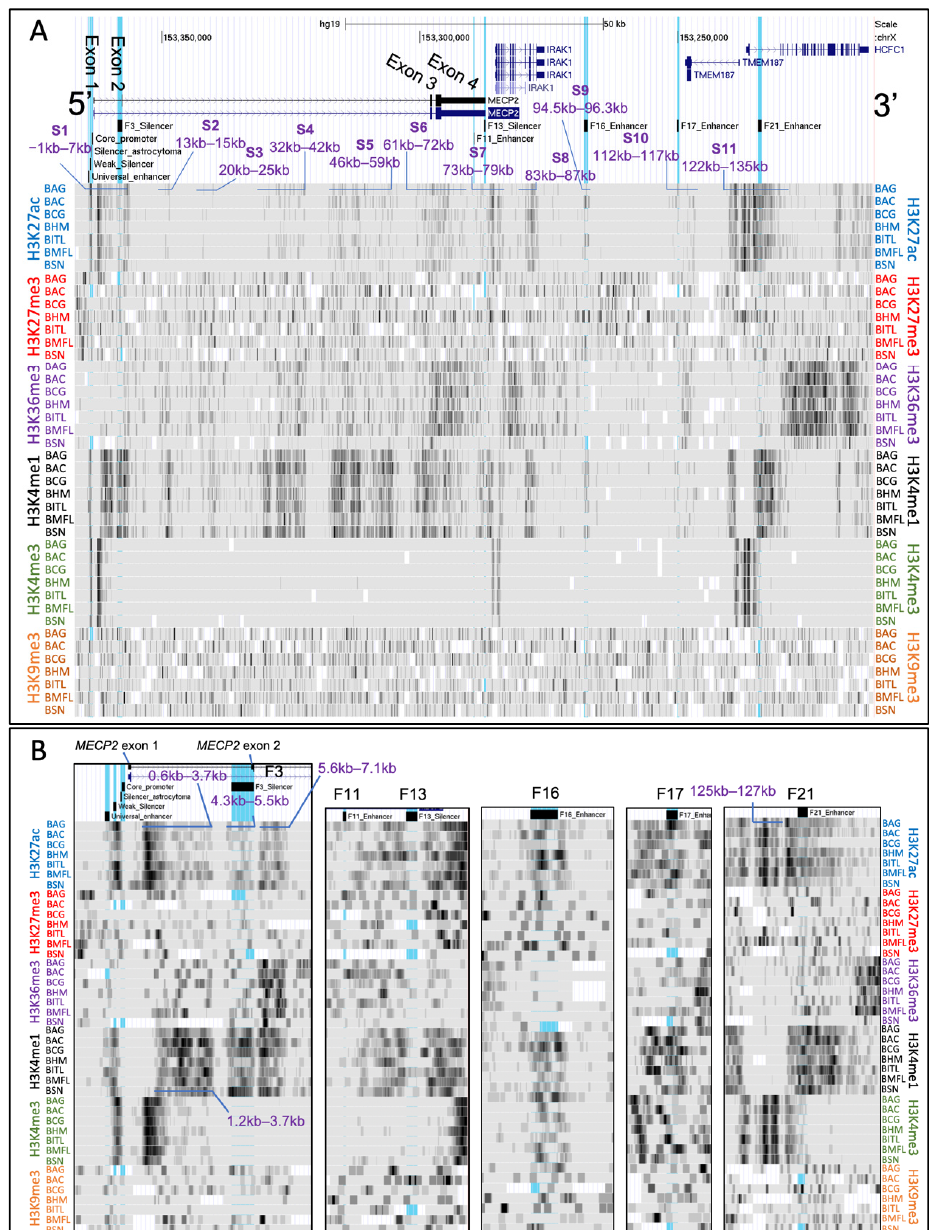
Figure 3. Histone post-translational modification profiles of 7 brain regions. ( A ) The chrX:153,212,176–153,366,832 genomic region of hg19 human genome assembly is displayed in UCSC genome viewing browser. Direction is 5 ′ –3 ′ (sense orientation relative to the MECP2 gene). Tracks displayed from top to bottom: UCSC genes, mapping of previously identified [55] cis- REs (F3-F21) to genome, histone modification CHIP-seq data tracks. Cis -regulatory elements (REs) are highlighted in blue in UCSC. Scale on top represents distance equivalent to 50 kb. MECP2 exons are labeled on UCSC Genes data track. Genomic segments with consistently high H3K27ac and H3K4me1 were labeled S1–S11. The distances are relative to the first nucleotide of MECP2 exon 1 (hg19 chrX:153,363,188). Labels consist of 3 letter code for brain region followed by histone PTM type. BAG: brain angular gyrus, BAC: brain anterior caudate, BCG: brain cingulate gyrus, BHM: brain hippocampus middle, BITL: brain inferior temporal lobe, BMFL: brain mid frontal lobe, BSN: brain substantia nigra. Darker areas represent more mapping reads binding to that specific genomic region, hence higher abundance of certain histone PTM. ( B ) Zoomed in portion of the genome focused on the MECP2 promoter and cis -REs. Cis -REs are labeled inside and on top of each box. Histone PTMs data are from